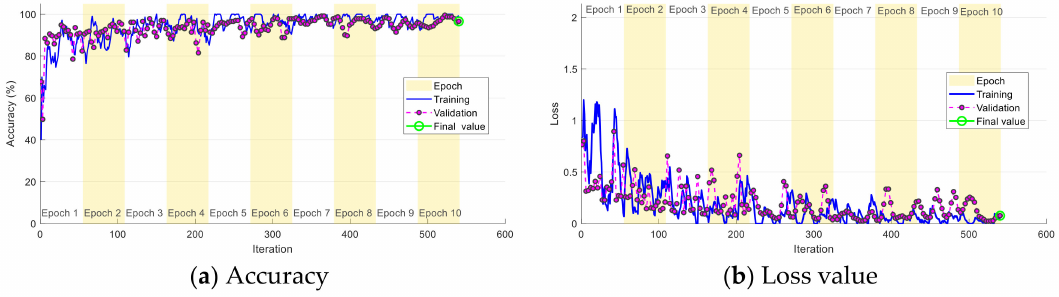
Figure 3. Convergence of the training and validation process of AlexNet. ( a ) Accuracy. ( b ) Loss